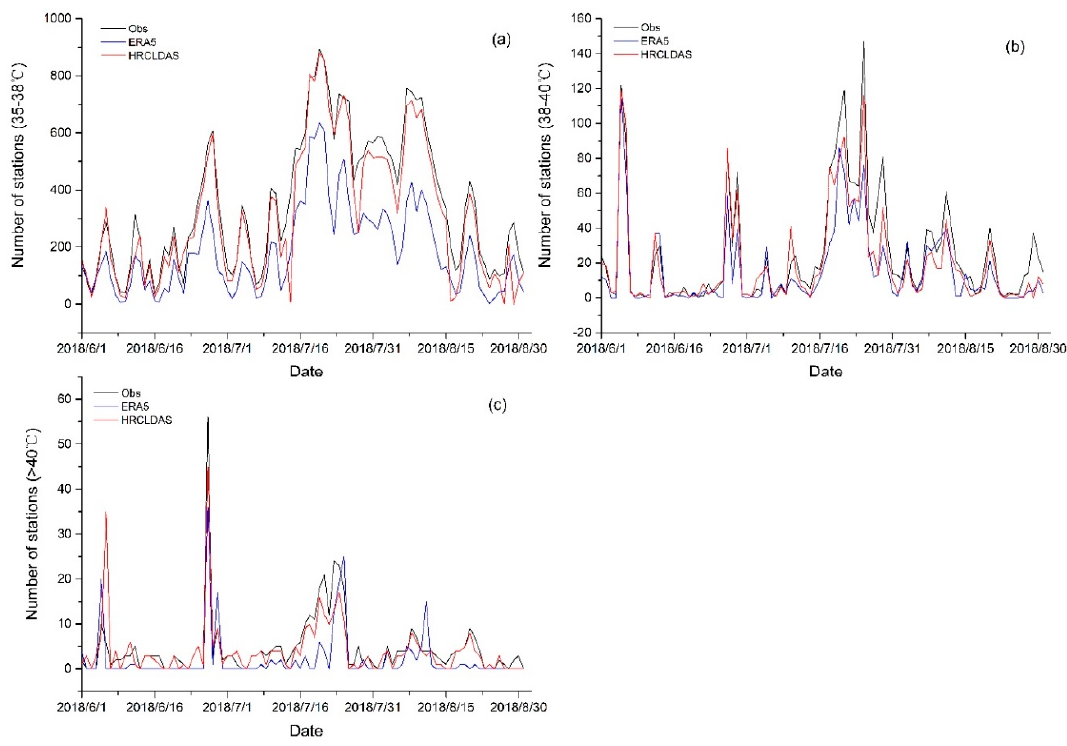
Figure 5. ( a ) Number of high temperature (35–38 °C) samples in summer 2018 for observations, ERA5 and HRCLDAS; ( b ) number of high temperature (38–40 °C) samples in summer 2018 for observations, ERA5 and HRCLDAS; ( c ) number of high temperature (>40 °C) samples in summer 2018 for observations, ERA5 and HRCLDAS.